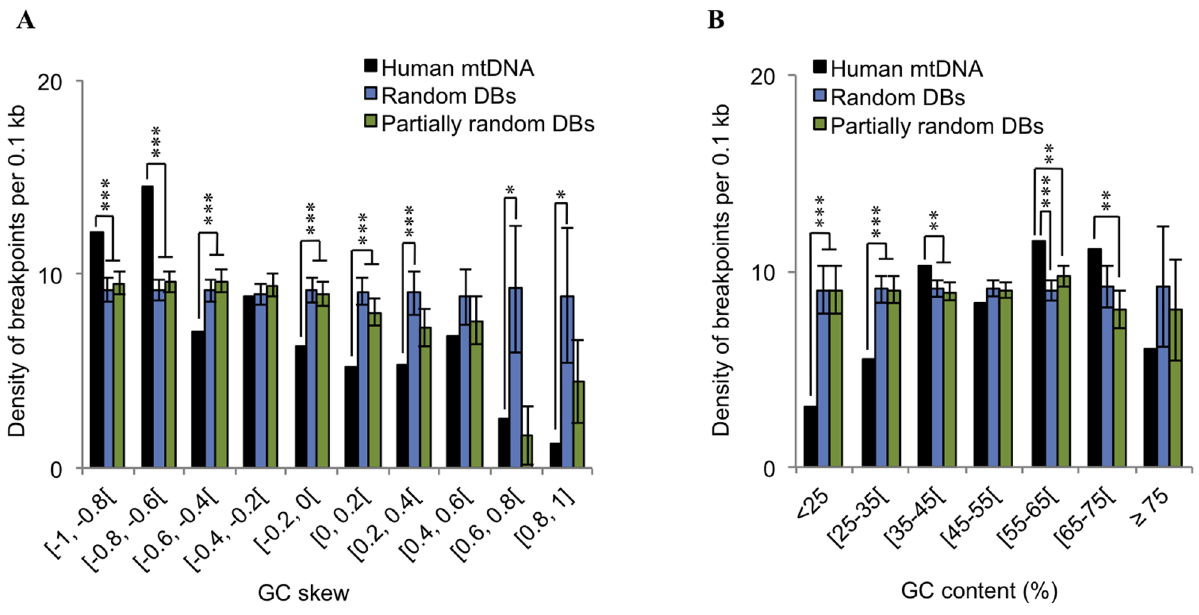
Figure 4. Impact of GC-skew and % GC-content in the distribution of deletion breakpoints. Variation in the density of deletion breakpoints per 0.1 kb with GC-skew (A) and % GC-content (B). Black bars represent the density values obtained for the human mtDNA, whereas blue and green bars respectively represent the values computed after randomization and partial randomization of breakpoint positions. Error bars represent standard deviations. * p , 0.05; ** p , 0.01; *** p ,